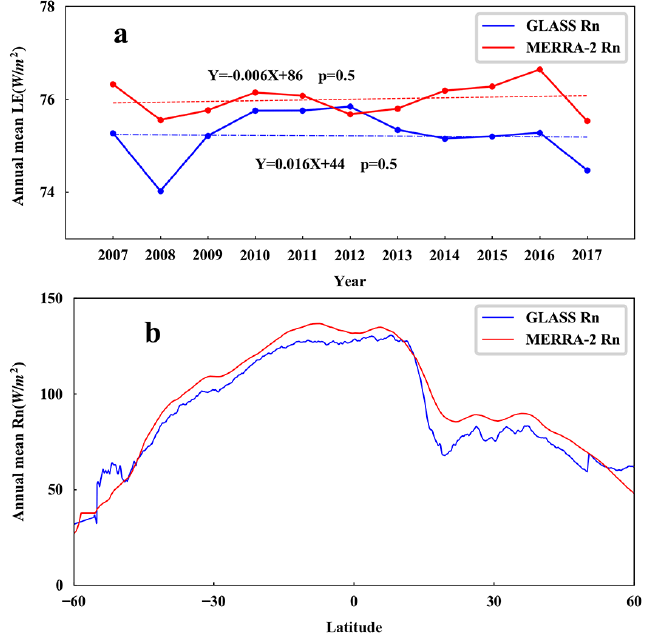
Figure 5. Trends in globally-averaged annual Rn ( a ) and latitude series of average Rn ( b ) for two Rn products during the period 2007–2017.